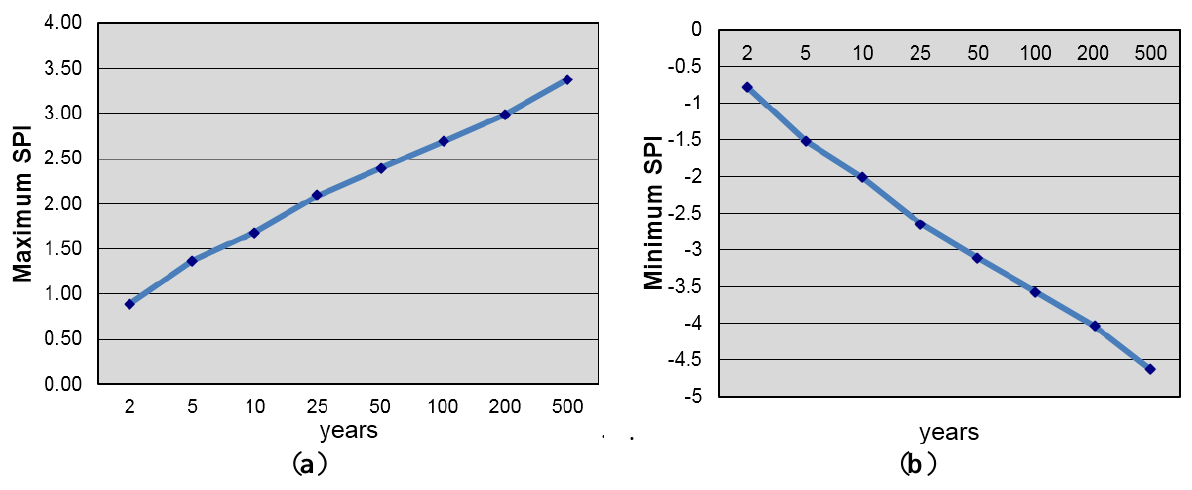
Figure 2. Maximum ( a ) and minimum ( b ) six-month standardized precipitation index in the Neuquén River basin vs. return period (in